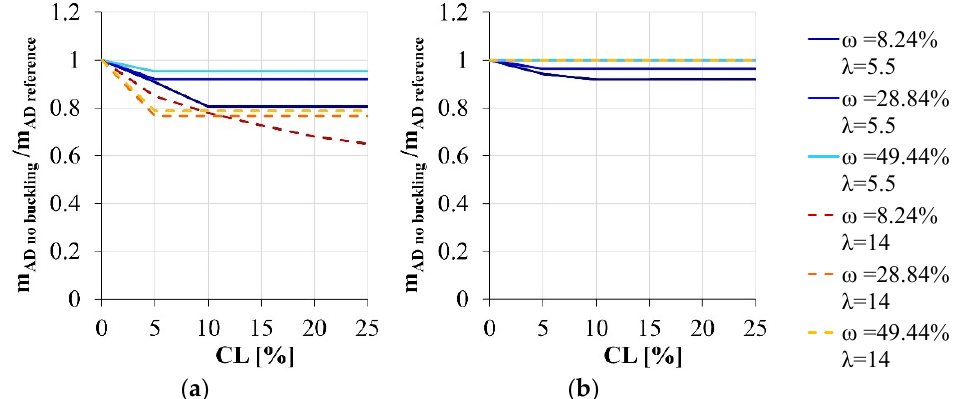
Figure 5. Load-carrying capacity variation due to the corrosion degradation: comparison between the simplified model disregarding the buckling effects and the reference section. ( a ) ν = 25.65%, ( b ) ν = 15.39%.